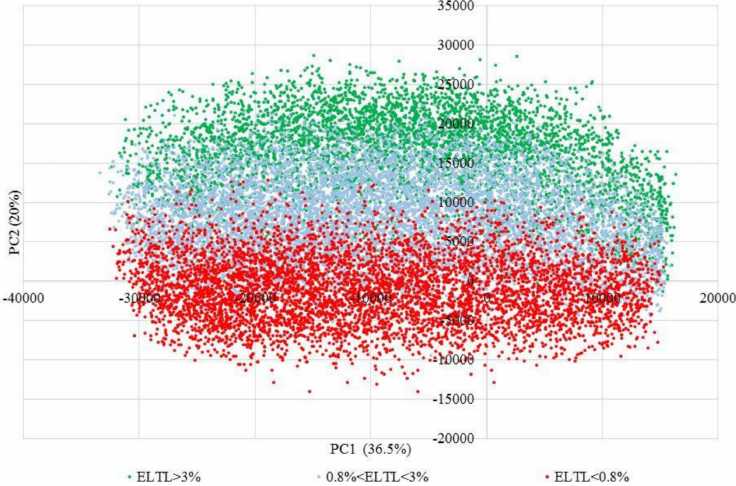
Figure 8. Bi-plot of ELTL values in the leaky ensemble.